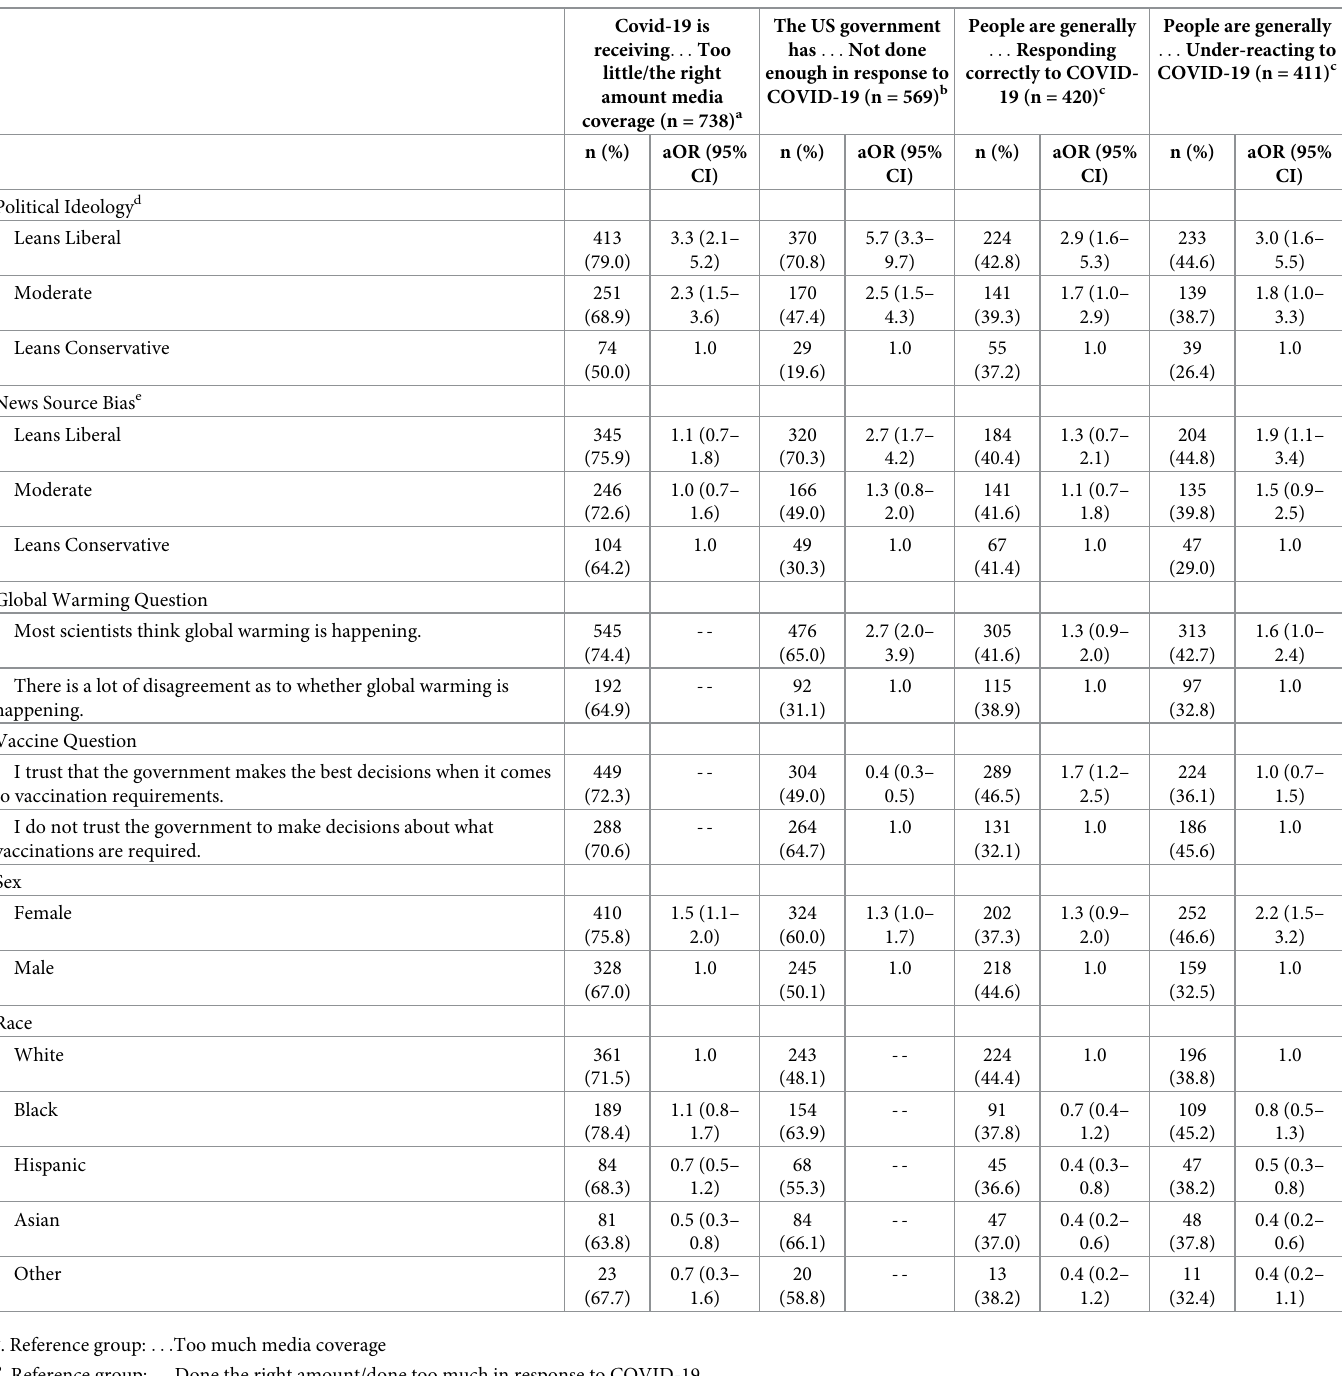
Table 2. Political and sociodemographic influences on attitudes about media coverage, government action, and community responses to COVID-19.